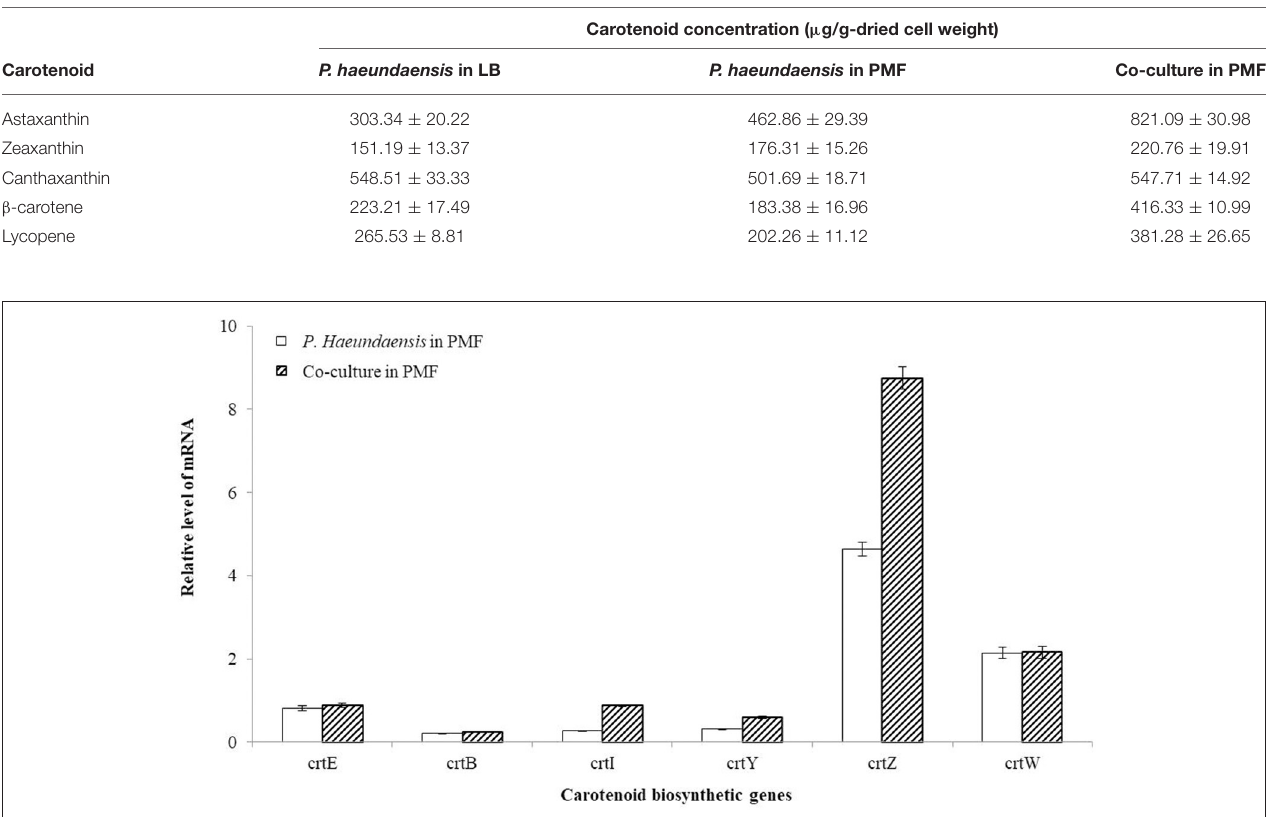
FIGURE 7 | Analysis of the RNA level of the co-culture. The RNA levels of the carotenoid biosynthesis genes crtE , crtB , crtI , crtY , crtZ , crtW , and housekeeping gene rpoB determined by real-time qPCR analysis. The RNA level of the carotenoid biosynthesis genes was analyzed with the Ct value, and the Ct value of rpoB was used as a control. The RNA level indicates mean ± standard